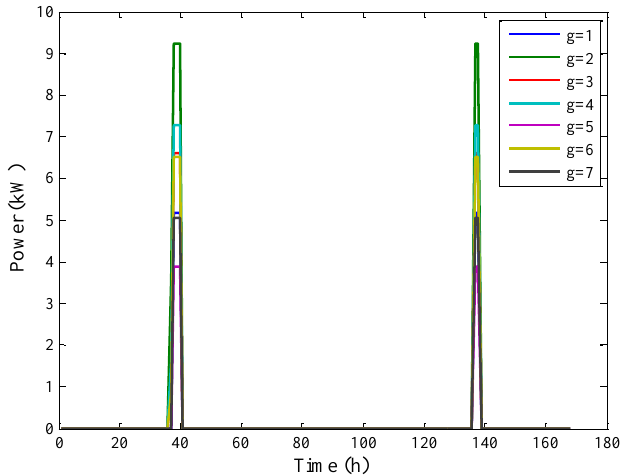
Figure 14. Power production of CG during the first week.